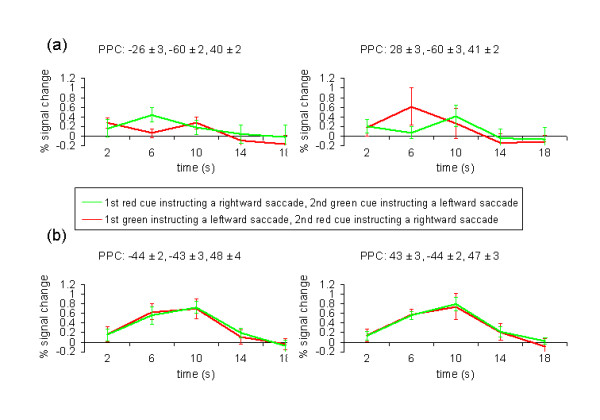
Percent signal change against time. The time courses were aligned to the onset of the first cue and averaged across subjects n = 13. (a) Signal time course for the posterior IPS. (b) Signal time course for the anterior/lateral IPS.